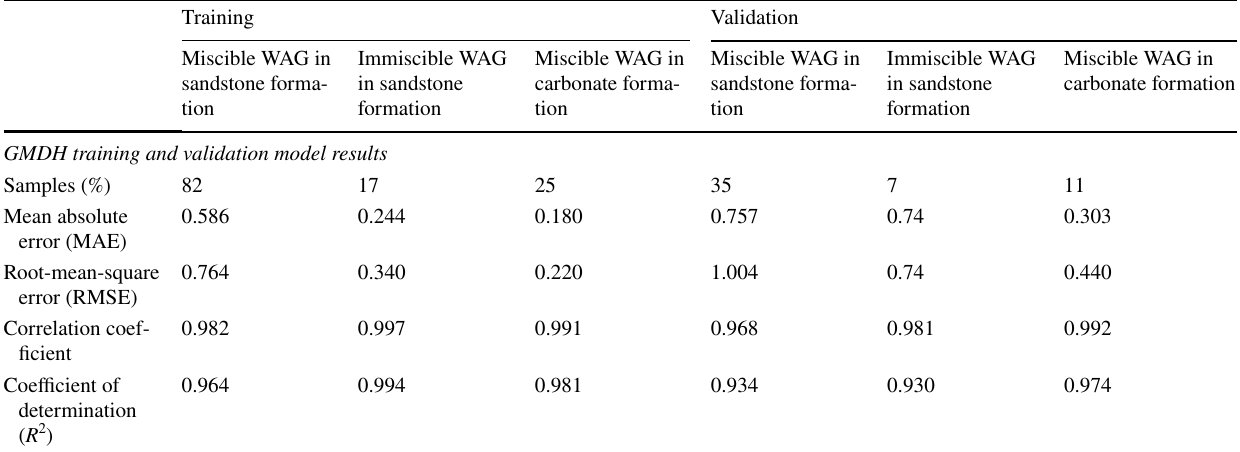
Table 5 GMDH WAG incremental recovery factor prediction model output